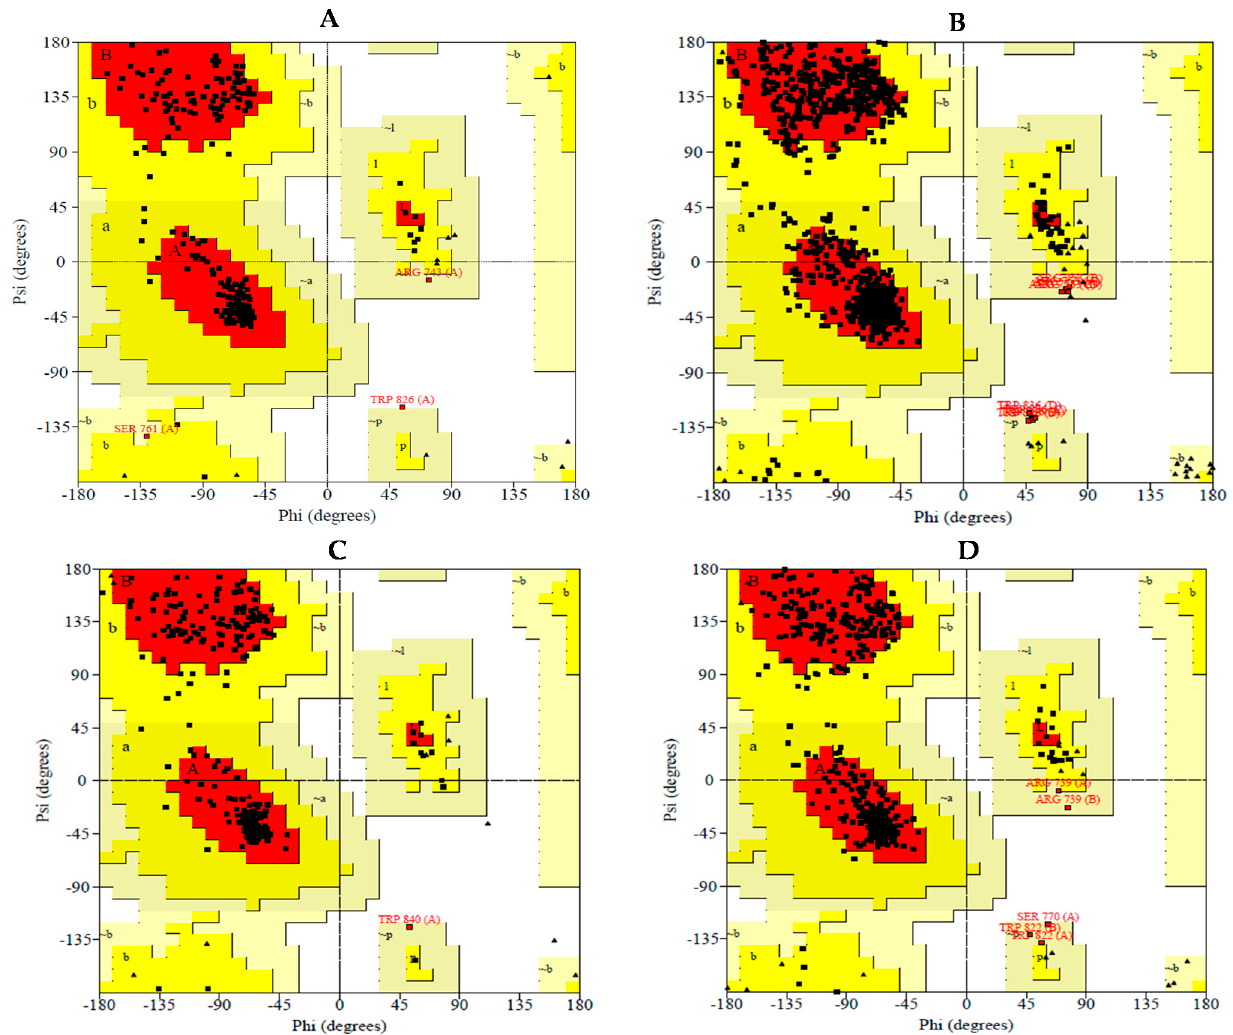
Figure 4. Ramachandran plots of EphB1 ( A ), EphB2 ( B ), EphB3 ( C ) and EphB4 ( D ); residues present in red-colored region signify the residues present in most favored region, additional allowed residues are found in the dark yellow-colored region, additional allowed residues are found in the light-yellow area and the disallowed residues are represented on white background color.